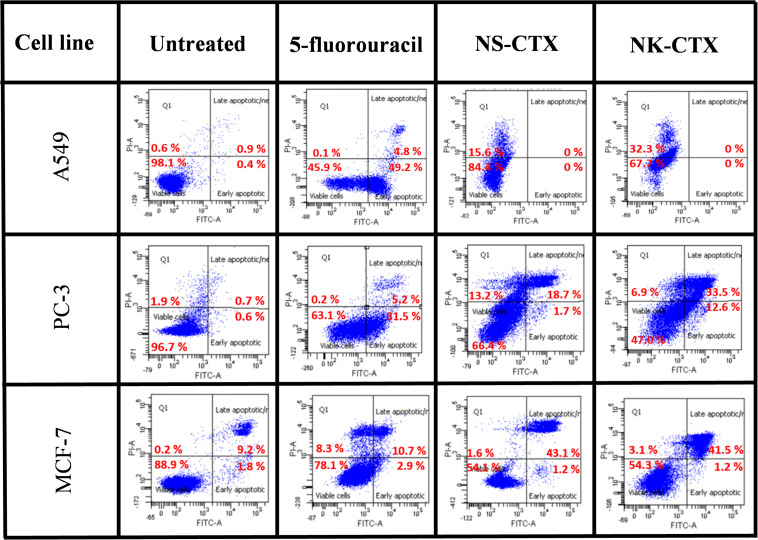
Dot plots showing the flow cytometric cell death mechanism of cancer cell lines (A549, PC-3, and MCF-7) induced by NS-CTX and NK-CTX treatment. All cell lines were treated with IC50 of NS-CTX and NK-CTX for 72 h. Cells were stained with Annexin-V and/or PI. Non-treated cells were used as negative control, and cells treated with 5-fluorouracil were used as positive control for apoptosis.